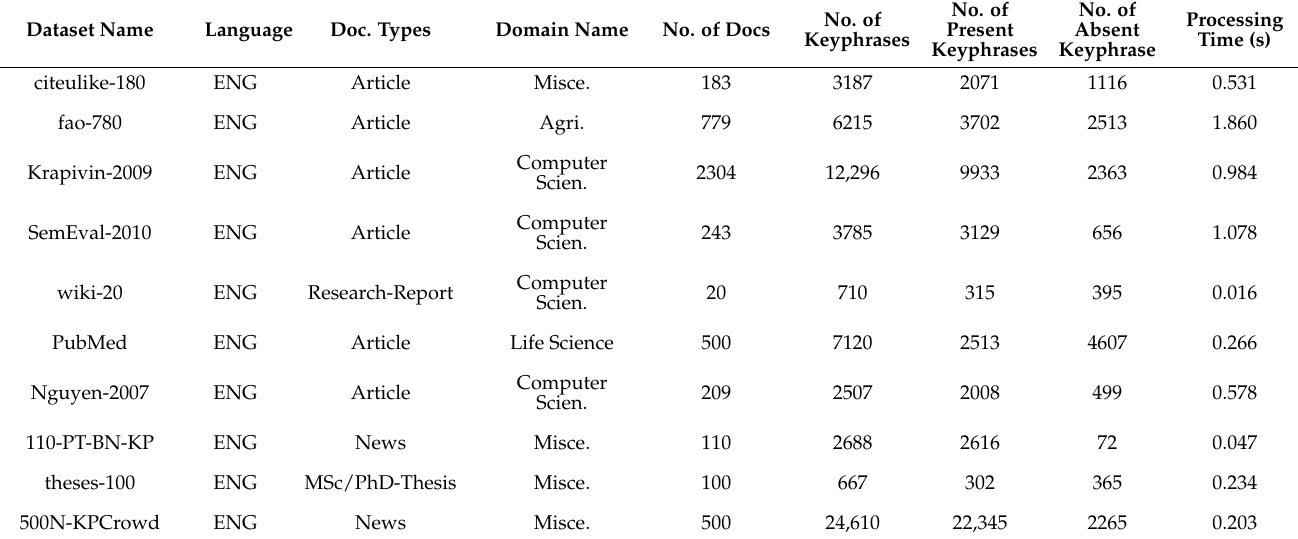
Table 1. Summary of the dataset for analyzing the present-absent keyphrases with processing